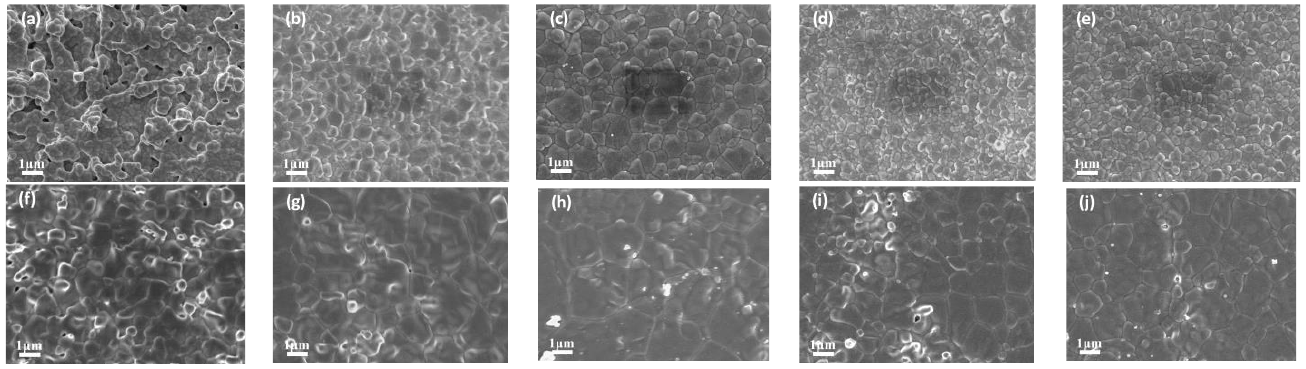
Figure 3. SEM under different sintering modes under 2 h holding time: ( a ) 5YSZ-1400 °C, ( b ) 5YSZ-1450 °C, ( c ) 5YSZ-1500 °C, ( d ) 5YSZ-1450-1400 °C, ( e ) 5YSZ-1500-1400 °C, ( f ) 8YSZ-1350 °C, ( g ) 8YSZ-1400 °C, ( h ) 8YSZ-1450 °C, ( i ) 8YSZ-1400 – 1350 °C, ( j ) 8YSZ-1450 – 1350 °C. Table 1. Sintered densities and grain size of 5YSZ and 8YSZ ceramics under various heating pa- rameters of two-step sintering. T1 (°C)